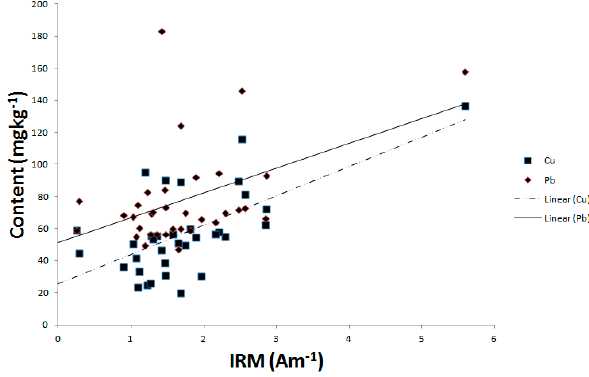
Fig. 10. Correlation between IRM 1T and content of Pb and Cu.